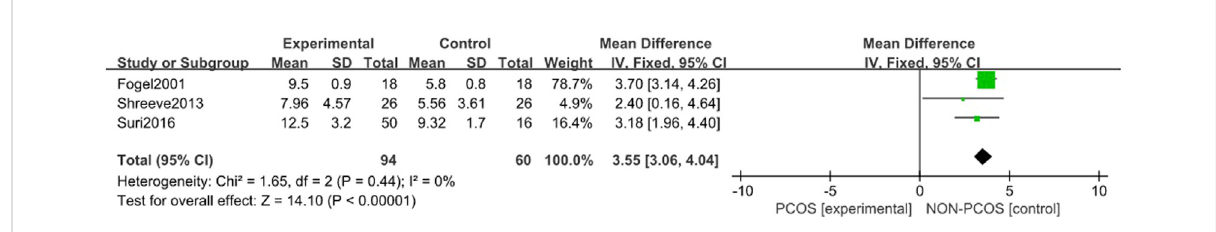
FIGURE 6 Forest plot of ESS scoress in PCOS group and control group (after removing heterogeneity studies).